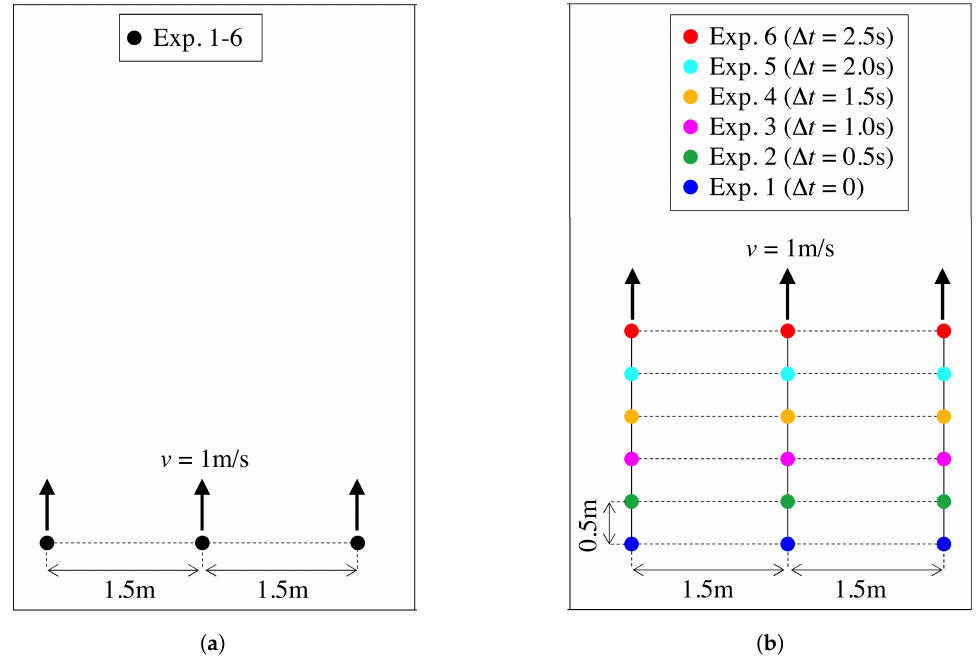
Figure 5. Starting user position in the experiment (3 users) and in the enlarged scenario (18 users), respectively. The extended dataset is obtained by aggregating the data of the 6 experiments with a relative time offset (as indicated in the legend) to form a regular 3 × 6 user grid. ( a ) Experiment Setting (3 Users); ( b ) Large-Scale Scenario (18